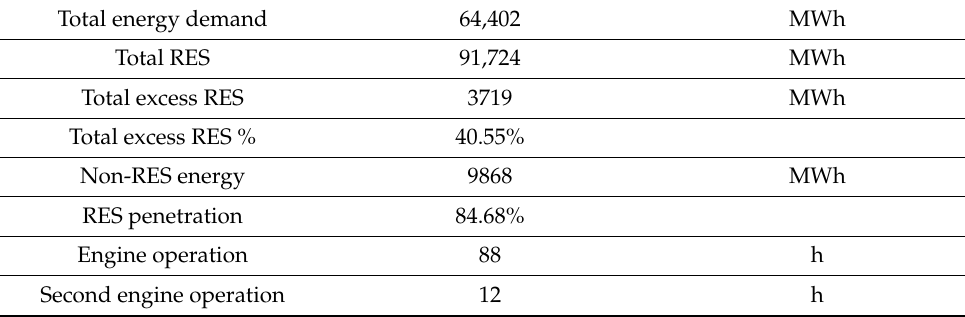
Table 3. Operation characteristics of the suggested hybrid system.